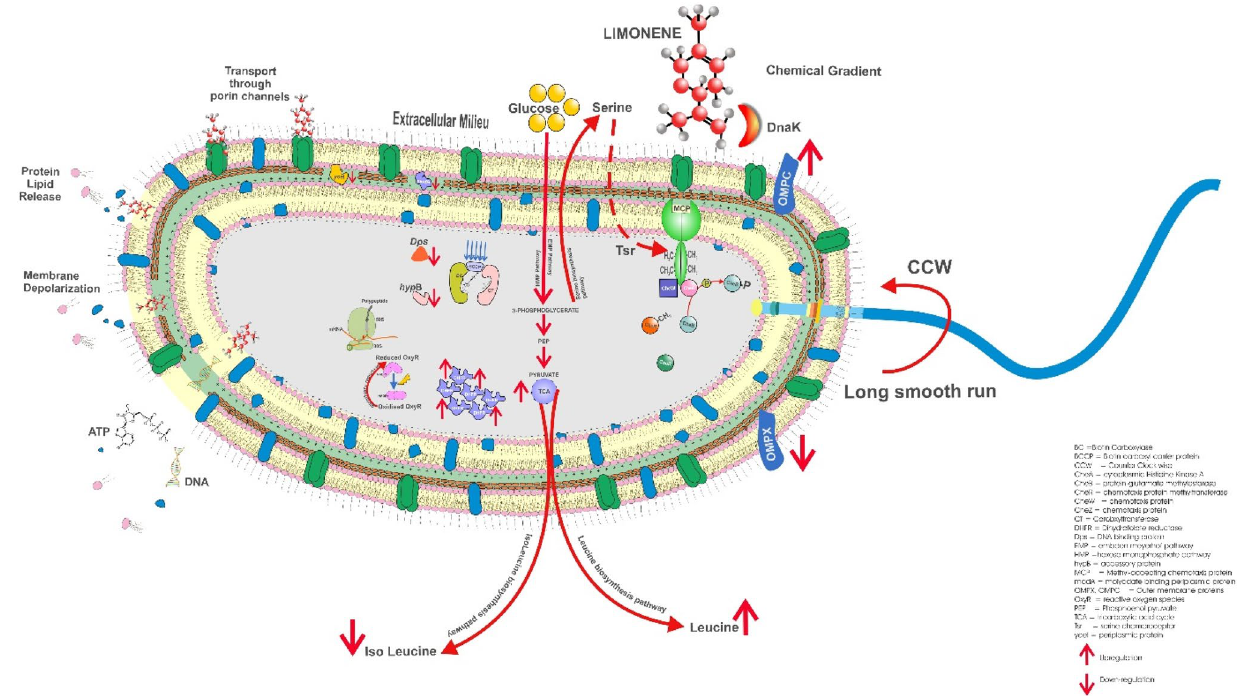
Figure 12. Antibacterial mechanism of Limonene against Escherichia